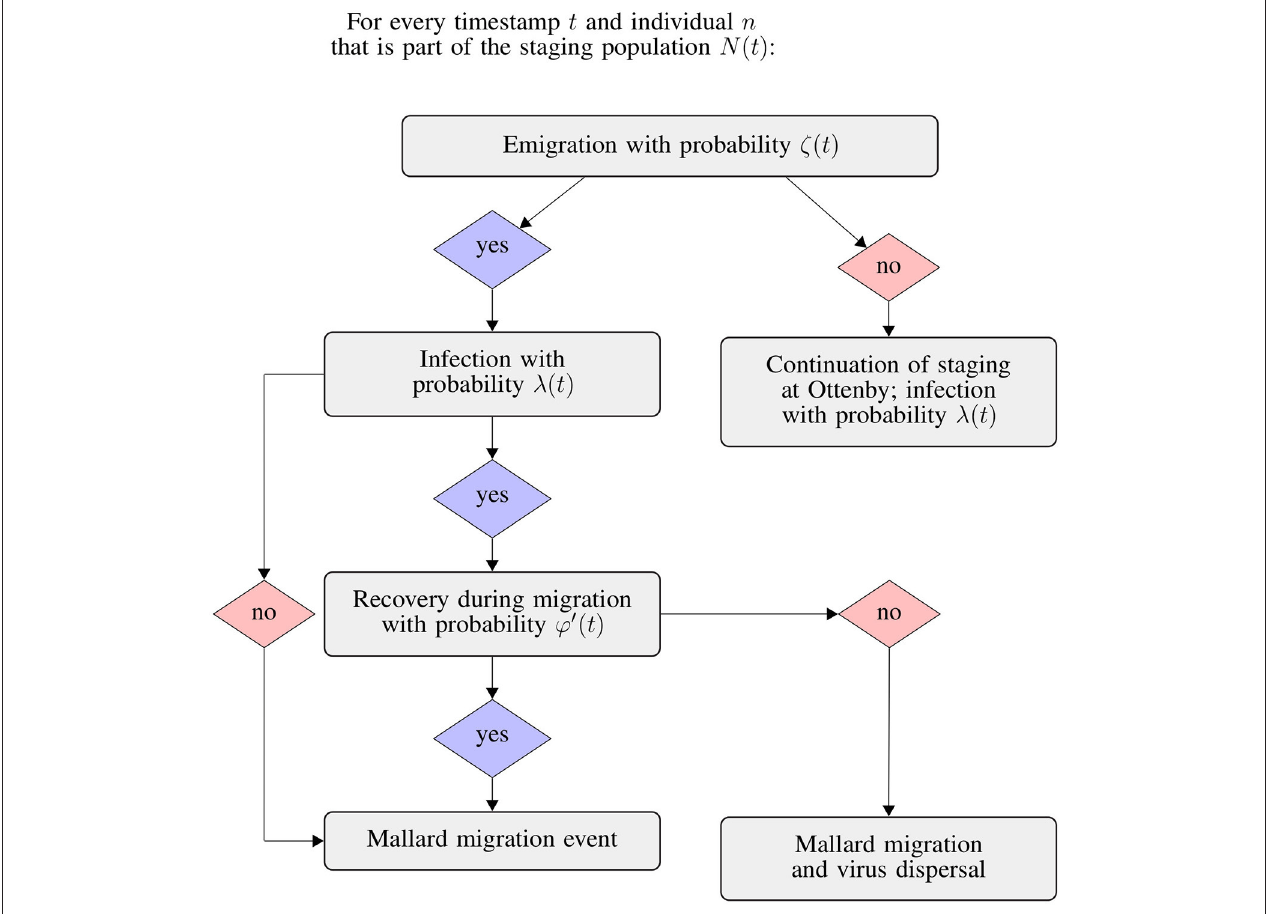
FIGURE 2 | Flowchart of the integrated SIR and emigration simulation. We repeated this process for each individual mallard considered to be a part of the staging population N at day t of the respective trapping